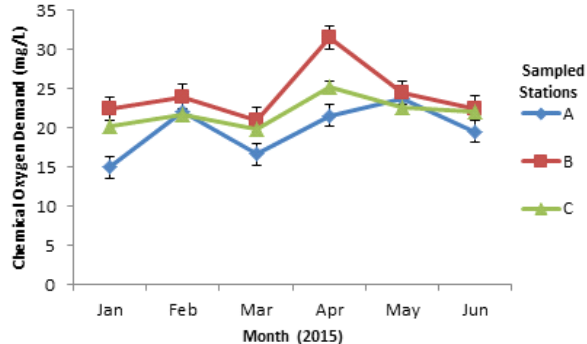
Fig. 10. The monthly mean variation in the chemical oxygen demand (mg/L) of the water sampled from Saba River